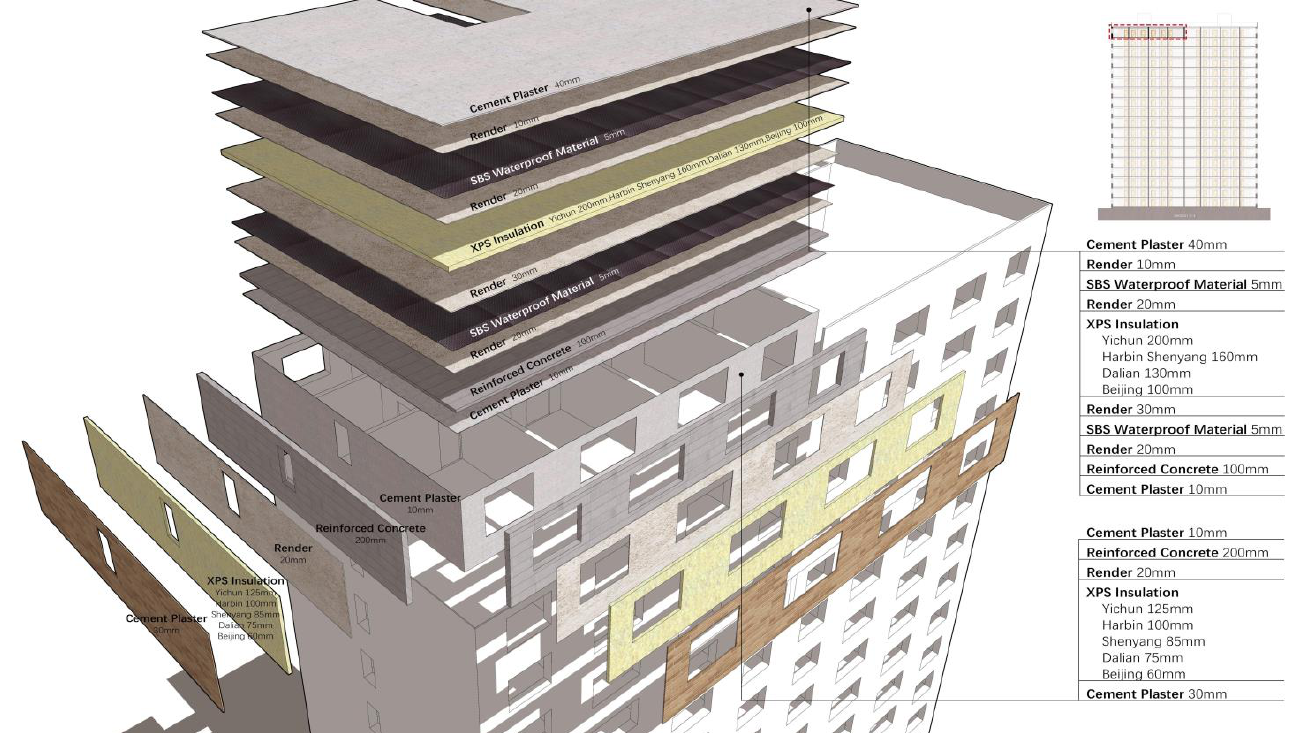
Figure 6. External wall and roof design for the RC residential buildings in the five cities. Data source: Code for thermal design of civil buildings (GB 50176-2016); drawn by the authors. Table 4. Envelope U-values.